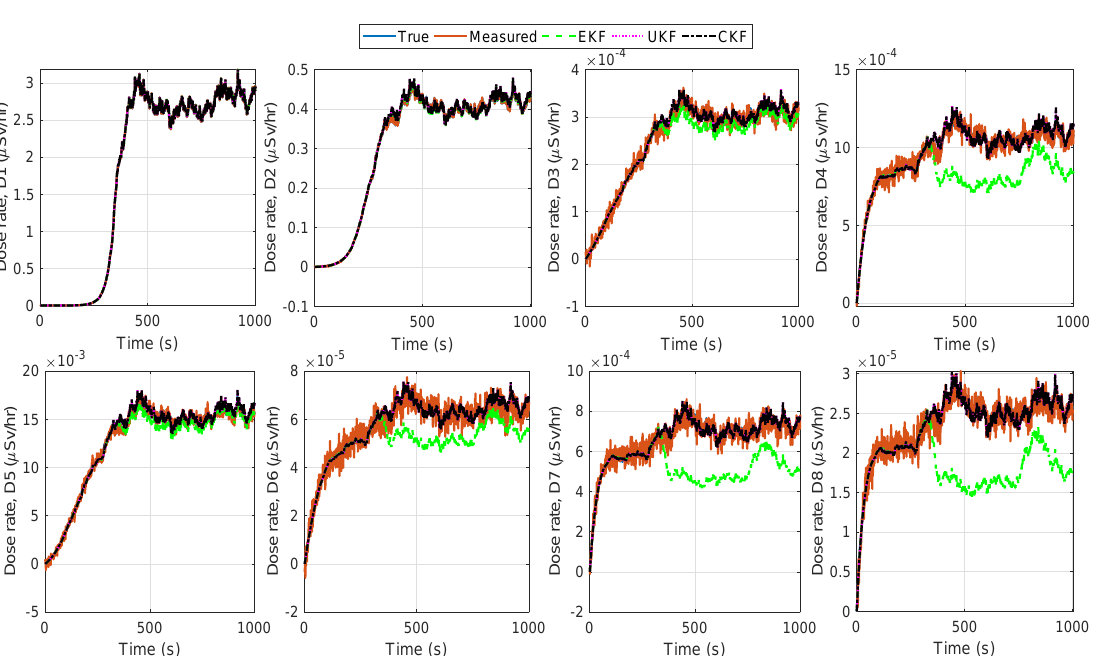
Figure 8. Variation in atmospheric turbulence.